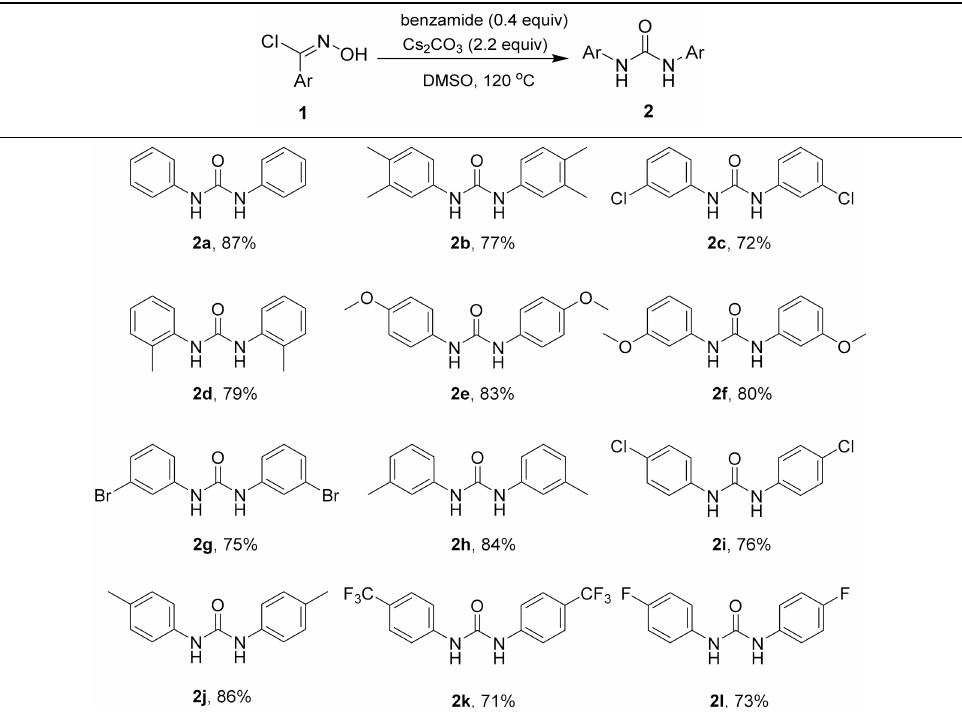
Table 2. Synthesis of 1,3-diphenylurea derivatives a,b .